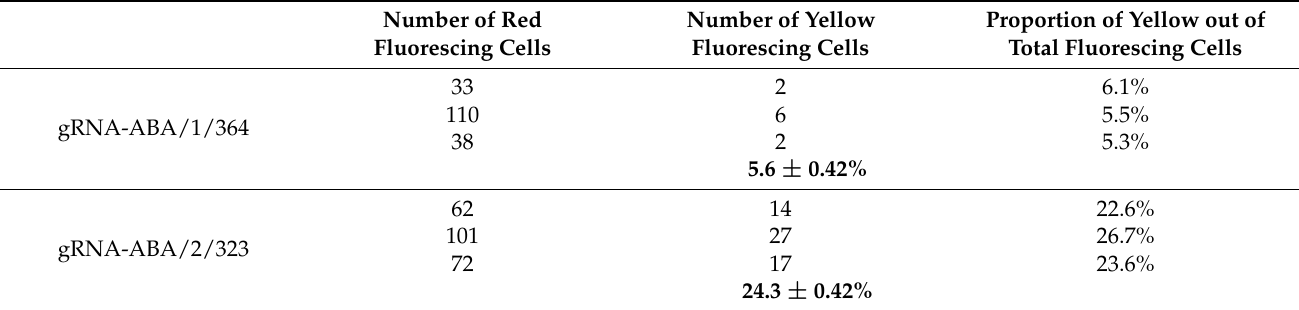
Table 2. Relative cleavage activity upon transient expression of cas9/gRNA and YFP/mCHERRY test constructs in barley leaf epidermis. Mean editing efficiency values ± SD is indicated in bold letters.